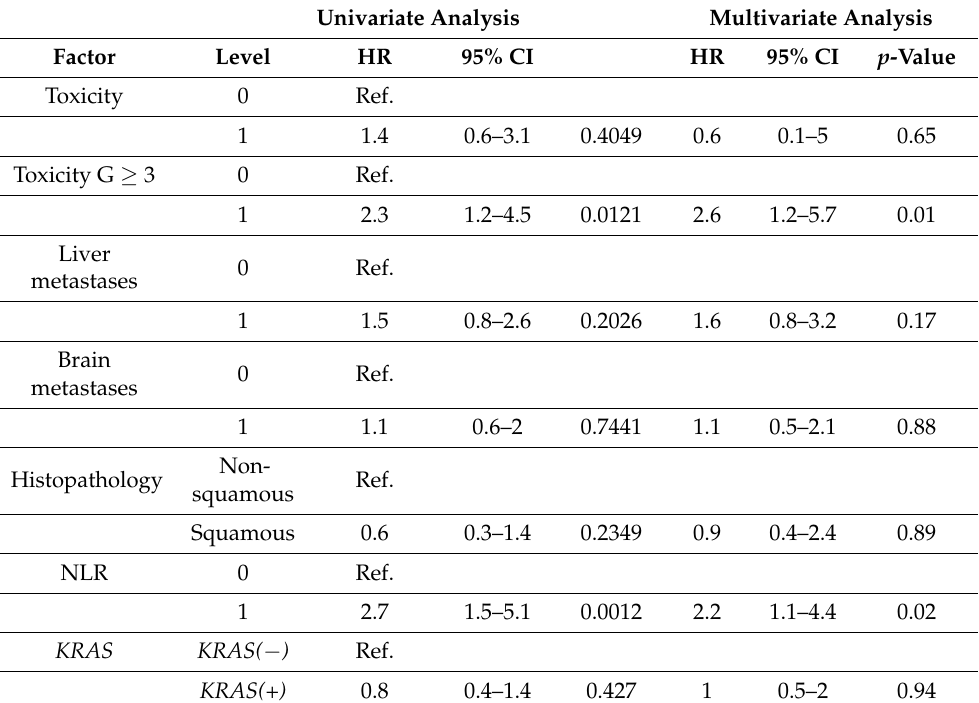
Table 4. Univariate and multivariate analysis of overall survival for the entire population.